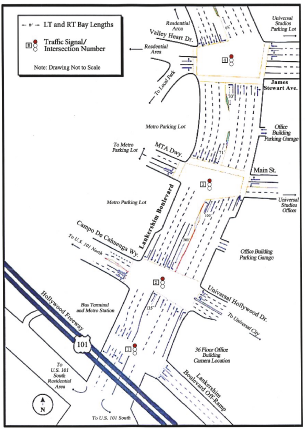
Figure 1: Study area: Lankershim Boulevard, where 101 is US Highway 101, and 1, 2, 3, and 4 are the intersection numbers.